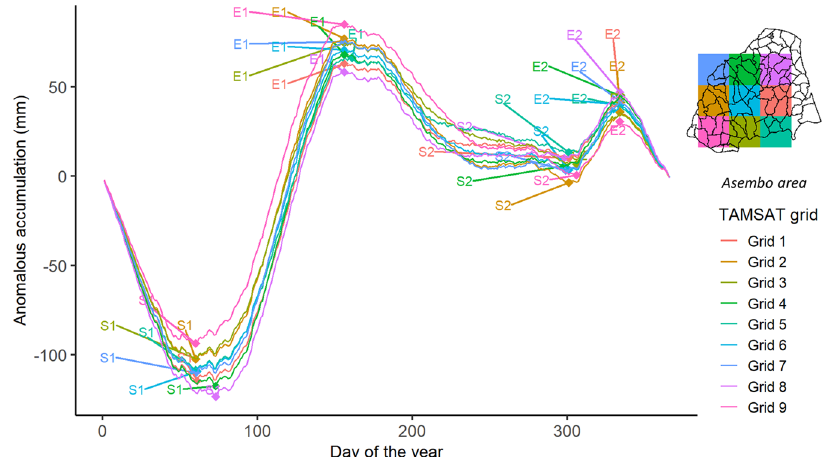
Fig. 3 Climatological anomalous rainfall accumulation curves for nine 4 km × 4 km TAMSAT grids covering the study area. ‘ S1 ’ and ‘ E1 ’ respectively represent the start and end of the long rainy season for each TAMSAT grid, whilst S2 and E2 are the start and end of the short rainy season respectively for each grid. The long dry periods are between ‘ E1 ’ and ‘ S2 ’ ; whilst the short dry periods are between ‘ E2 ’ and ‘ S1 ’ .